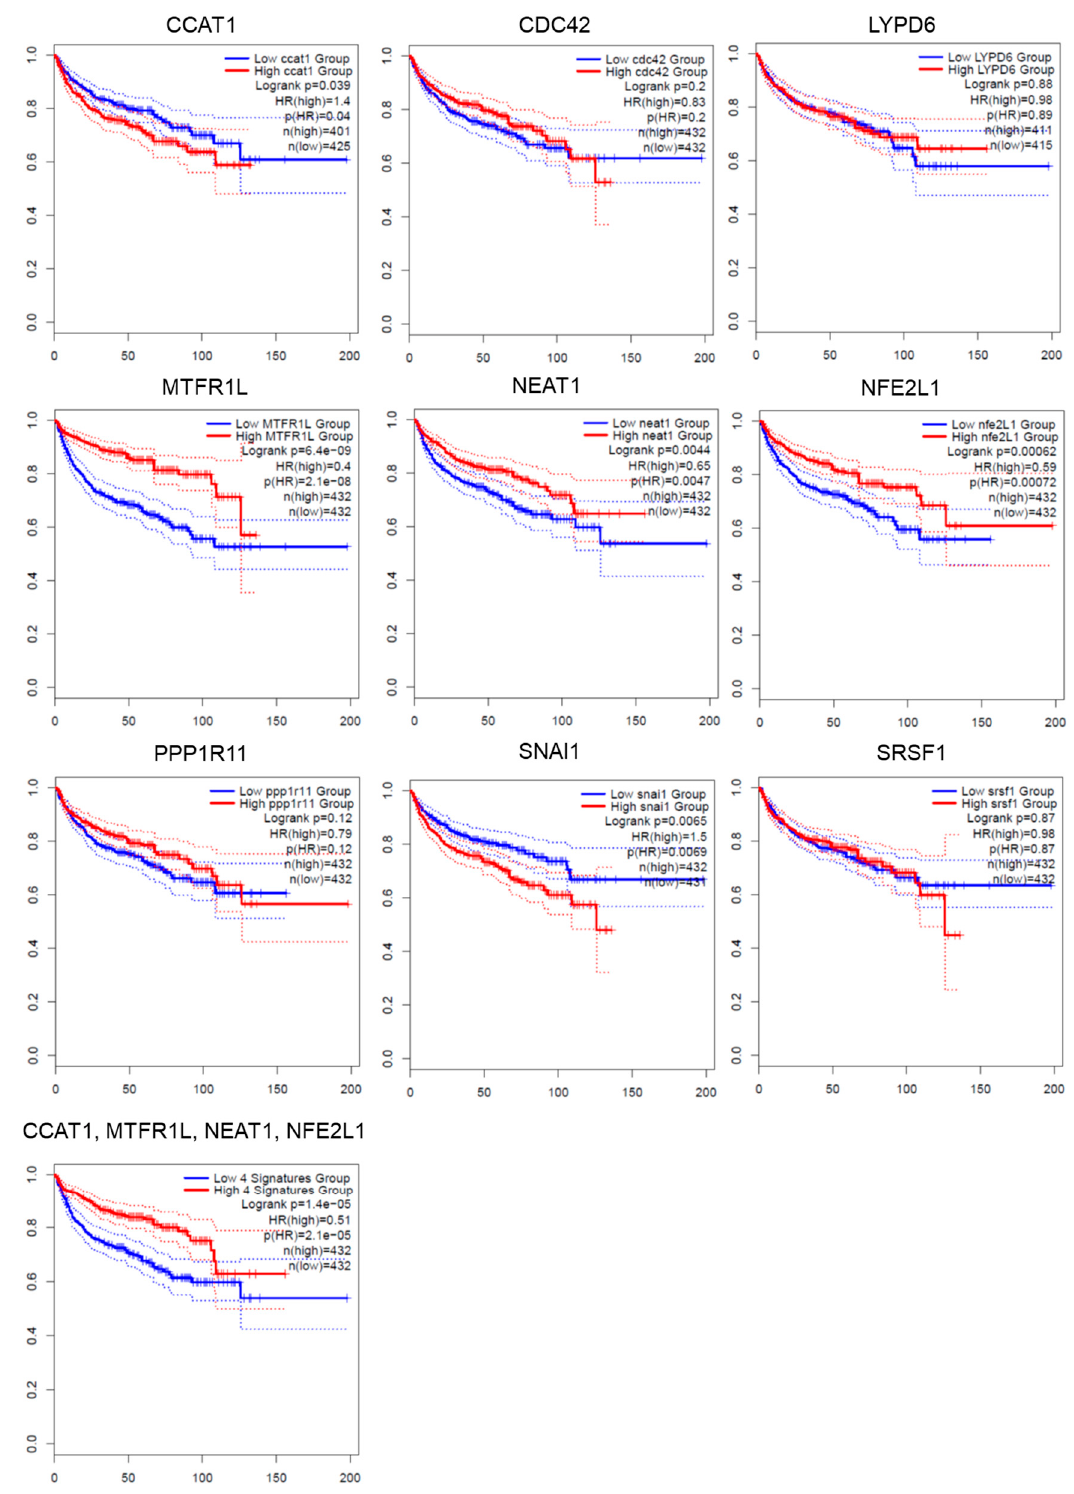
Figure 4. The disease-free survival comparing the high expression (red line) and low expression (blue line) of patients with kidney renal clear cell carcinoma, kidney renal papillary cell carcinoma, and kidney chromophobe were created from data in the GEPIA2 database. The gene expression was divided by median expression value. The number in parentheses indicated the number of groups. The logrank p value and hazard ratio (HR) was shown on each figure. 95% confidence interval was shown as dotted line.